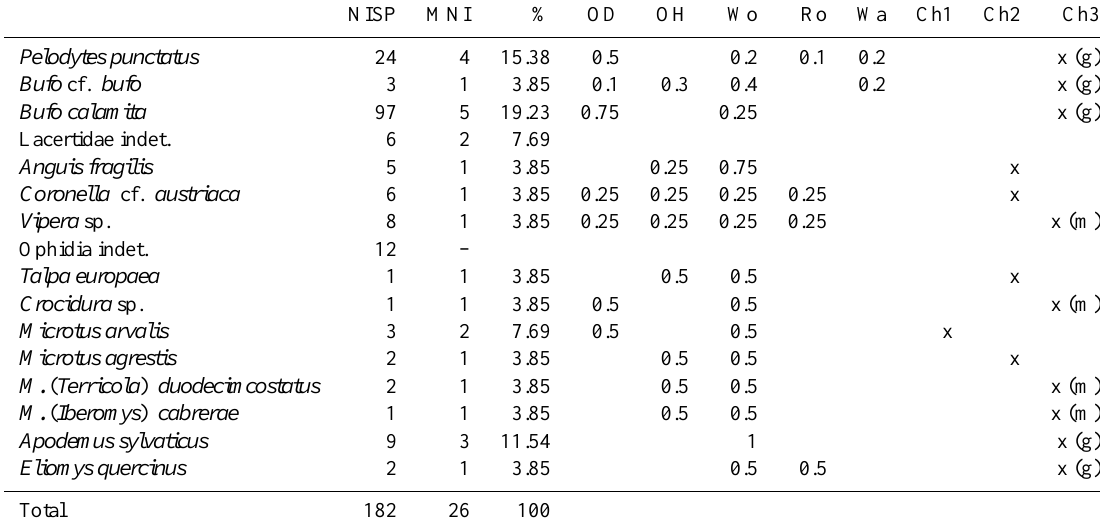
Table 2. Representation of the number of identified specimens (NISP), the minimum number of individuals (MNI) and the percentage of the MNI (%) for the small vertebrates from Canyars, and the small-vertebrate distribution by habitat and by chorotype. OD, open dry; OH, open humid; Wo, woodland/woodland-edge; Ro, rocky; Wa, water; Ch1, chorotype 1; Ch2, chorotype 2; Ch3, chorotype 3; (g), generalist; (m), Mediterranean requirements; indet., indeterminate. x represents the relationship between chorotypes and